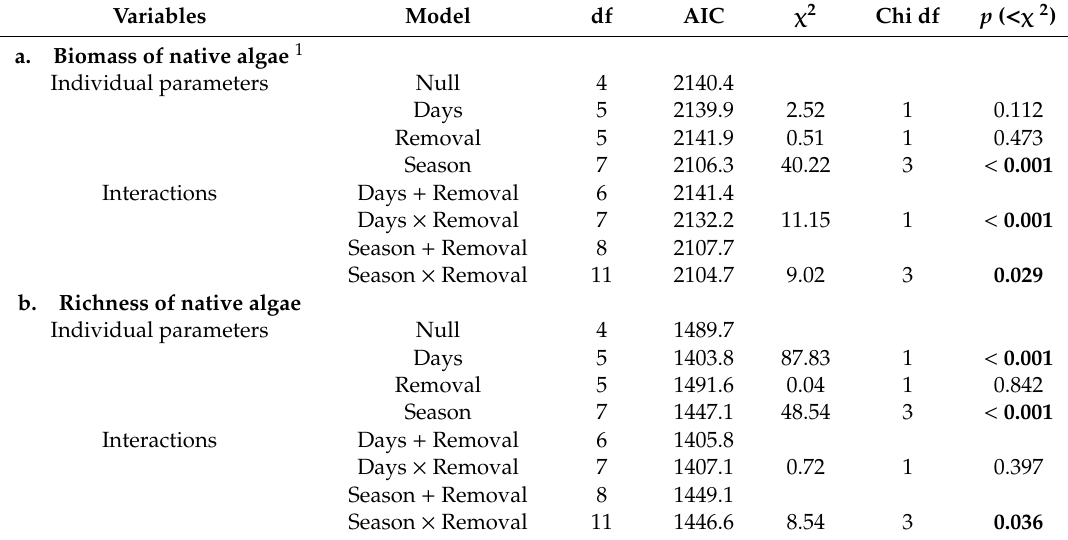
Table 1. Results from likelihood ratio tests and model selection for determining the influence of experimental removal of Sargassum horneri on the ( a ) biomass and ( b ) taxonomic richness of native algae. Independent variables included were: Days since the start of the experiment (Days), S. horneri removal treatment (Removal), and season of the sampling period (Season). Individual variables were tested against the null model and interactions were tested against additive models with the same parameters. Models were ranked according to Akaike Information Criterion (AIC) selection with lower AIC values indicating a better fit of the data. Significance was based on chi-square test statistics. Statistically significant p -values are in bold text.